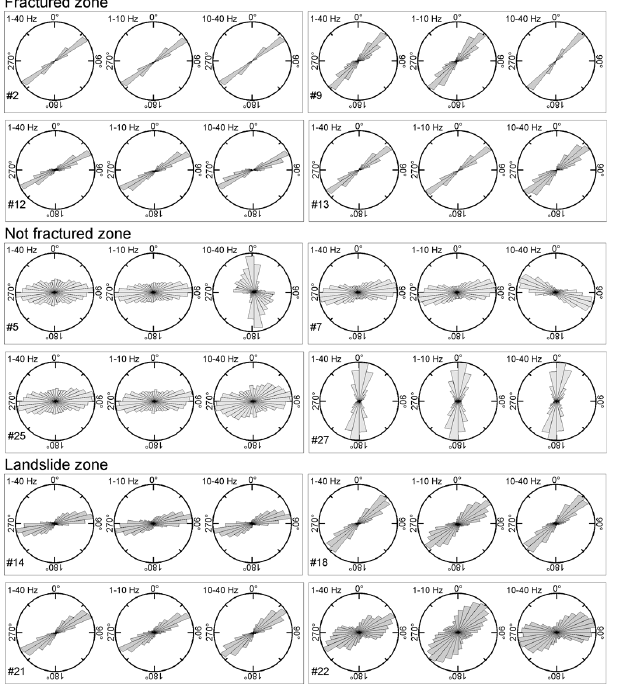
Fig. 10. Examples of rose diagrams at representative ambient noise recording sites.